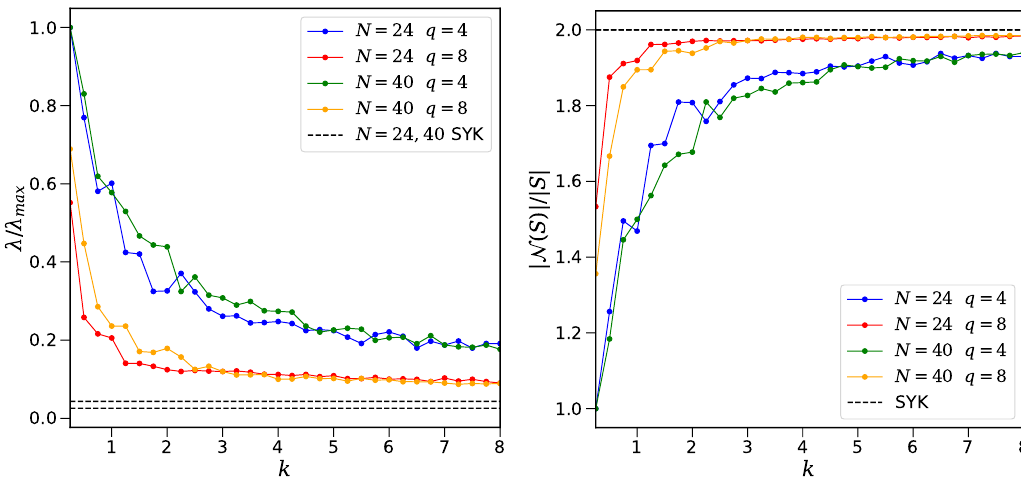
Figure 3. Left: spectral gap normalized by the largest eigenvalue of the adjacency matrix. Right: bound on vertex expansion (3.17) for subsets S ⊂ V smaller than half the size of the vertex set V . The dashed lines are the values for the all-to-all